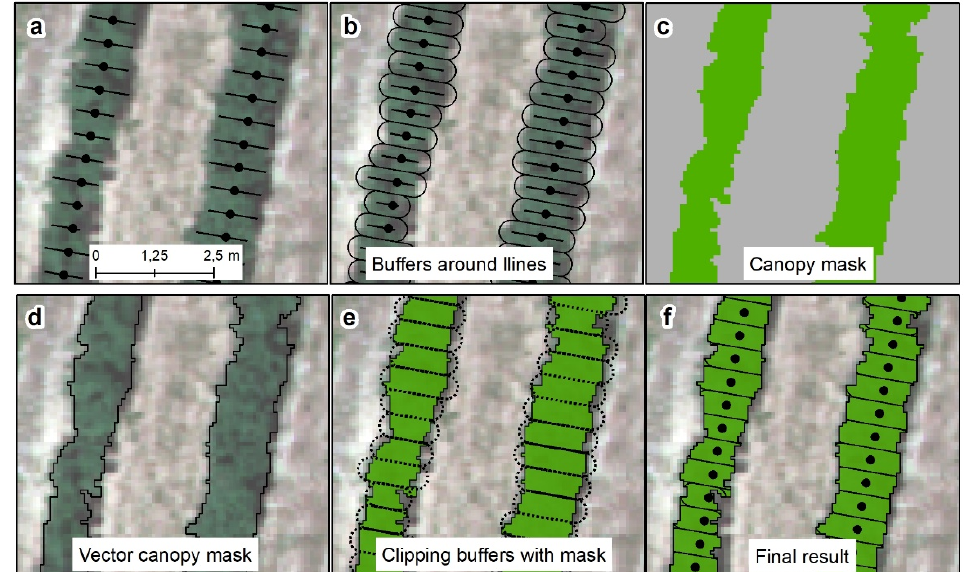
Figure 4. Process to build the projected hedgerow canopy polygons to compare the structural and geometric almond vegetation data with the vegetation indices from the UAV image. ( a ) Delineation of perpendicular lines along the tree rows passing by the centroids where LiDAR data were summarized; ( b ) creation of buffers of 0.25 m radius; ( c ) creation of the canopy mask by supervised classification; ( d ) vectorization of the mask; ( e ) clipping of the mask with the buffers; ( f ) final result of the reference areas to summarize the vegetation indices. Image background is a blurred RGB UAV image.